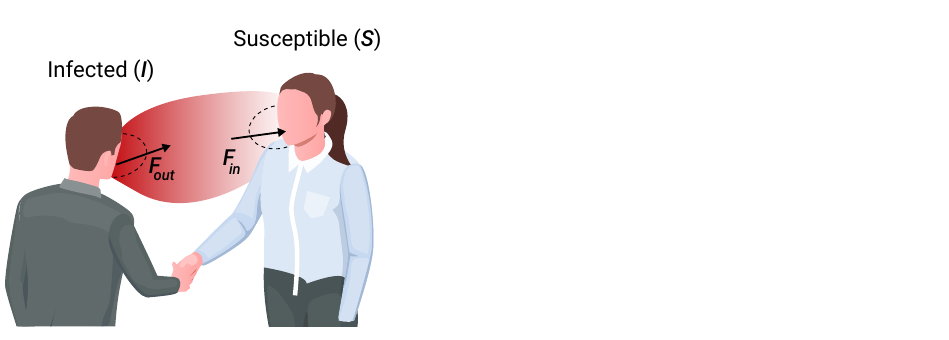
Figure 1. A schematic view of the model’s dynamics. F out and F in are the force of air getting out and in (with the pathogen’s particles) during an individual’s breathing